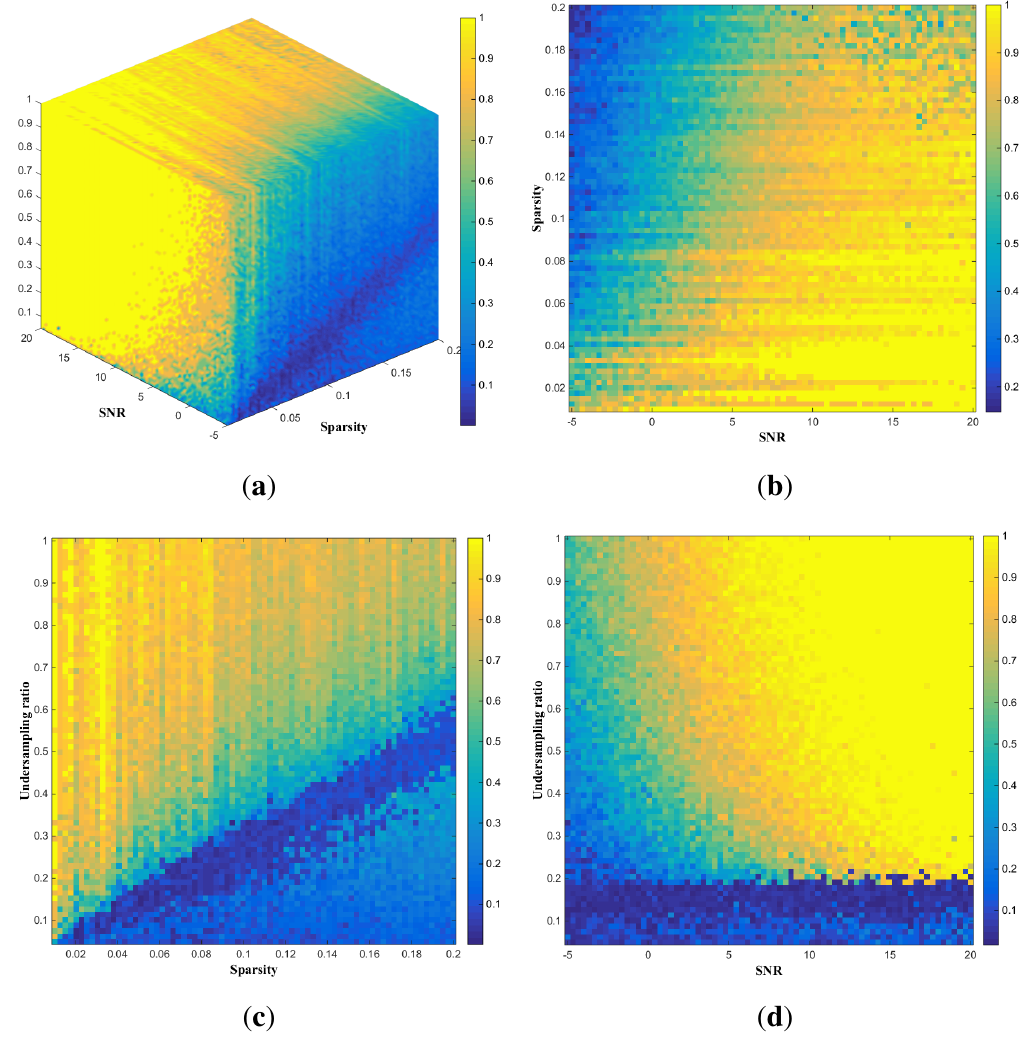
Figure 3. Computationally-derived relationships among sparsity, SNR and undersampling ratios (distortion level = 0.01): ( a ) necessary undersampling ratios in relation to scene sparsity and SNR; ( b ) sparsity-SNR relationship with undersampling ratio = 75%; ( c ) sparsity-undersampling ratio relationship with SNR = 5 dB; and ( d ) undersampling ratio-SNR relationship with sparsity =